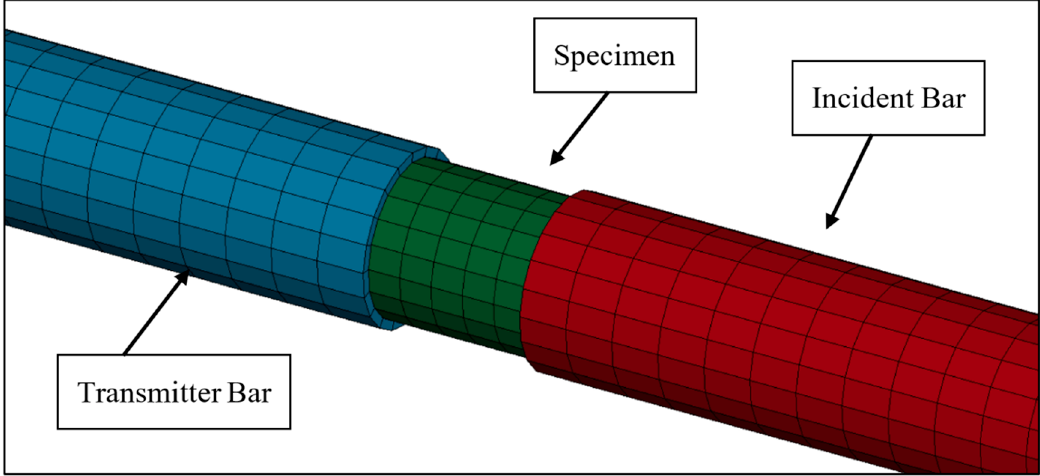
Figure 9. Incident bar, specimen, and transmitter bar position on the simulation. The gap between the bars and the specimen is set to be 0.01 mm to avoid any initial penetration during simulation. Table 4. Length and diameter of the impactor bar, incident bar, transmitter bar, and the specimen. Part